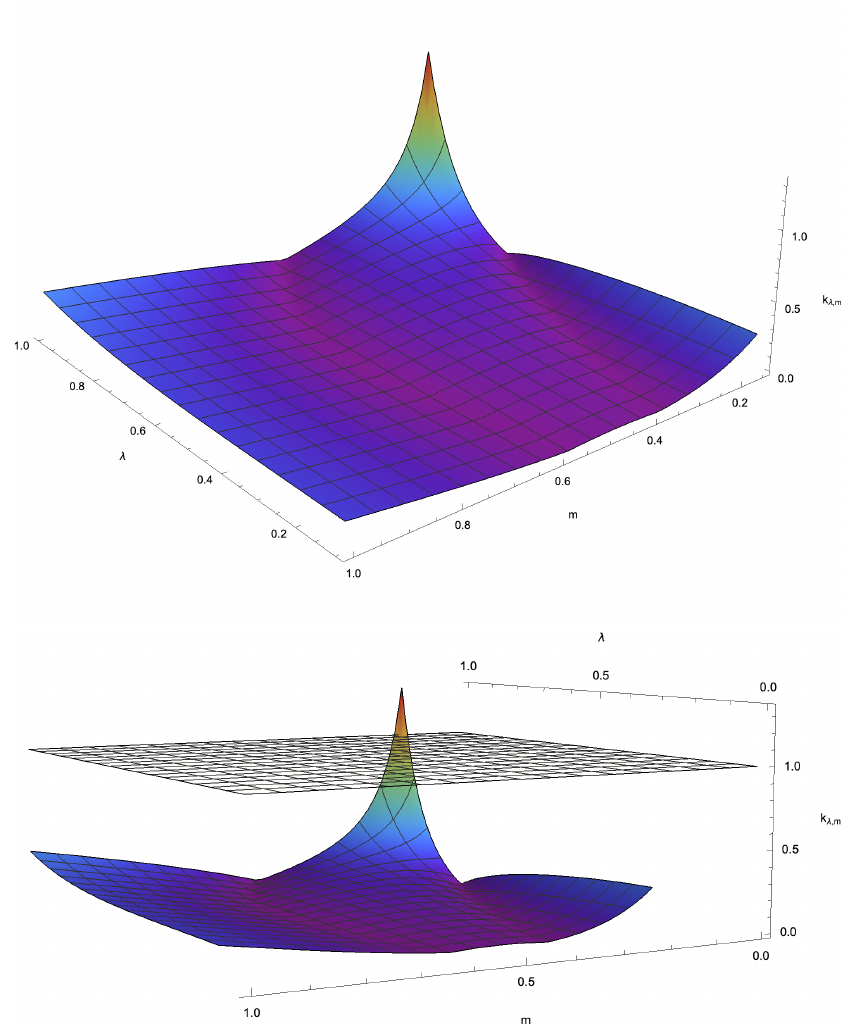
Figure 8. La Cierva’s surface, S = { ( λ , m , k λ , m ) : ( λ , m ) ∈ R } , where R = [ 0,1 ] × [ 0.15,1 ] (above). The plane { ( λ , m ,1 ) : ( λ , m ) ∈ R } has been graphically displayed as a benchmark regarding the limit of the stability zone for la Cierva’s surface